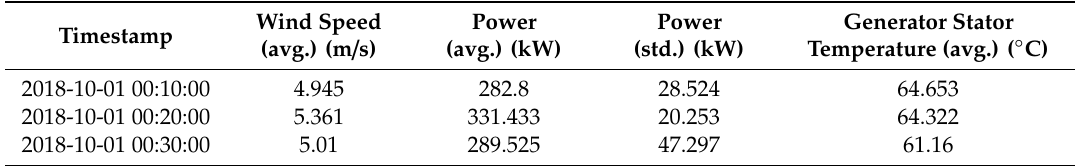
Table 1. Sample of the Supervisory Control and Data Acquisition (SCADA) dataset. Average (avg.) and standard deviation (std.) values are